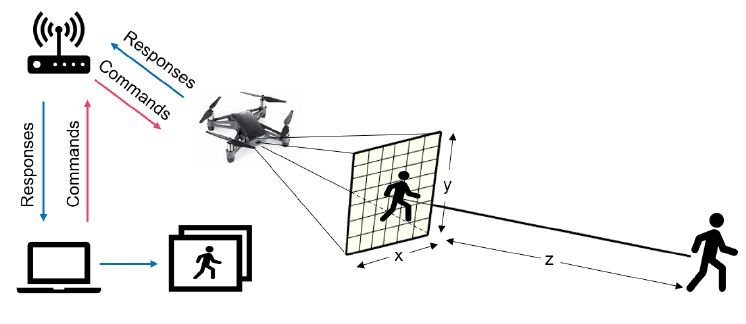
Figure 3. Overview of human motion tracking using Tello EDU drone.